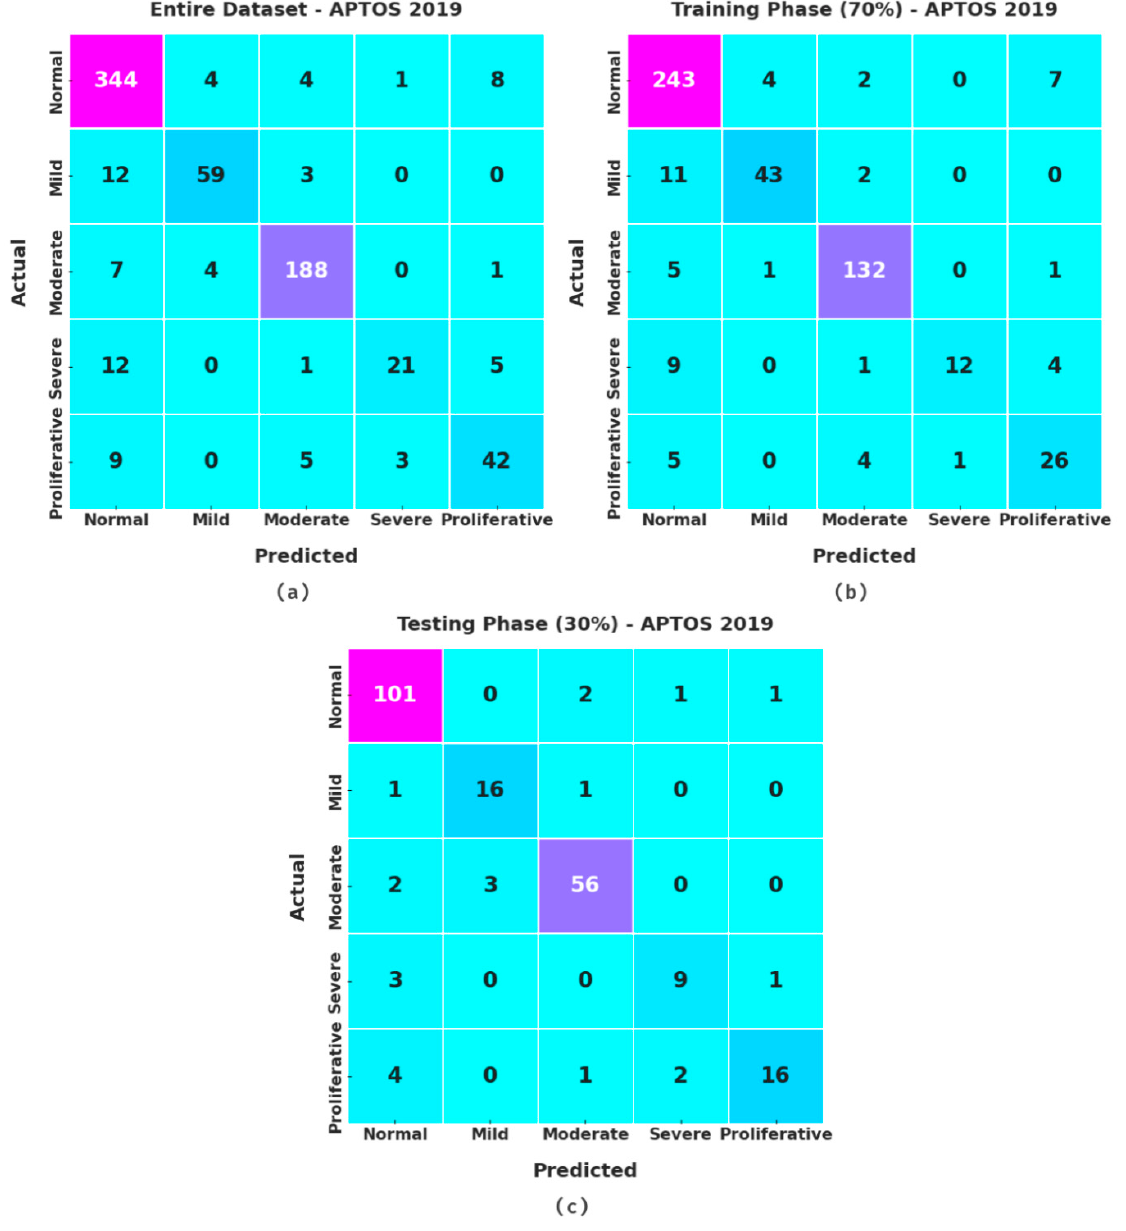
Figure 3. Confusion matrices of the XAITO-DRGC approach under the APTOS 2019 dataset ( a ) entire dataset, ( b ) 70% of TR data, and ( c ) 30% of TS data.